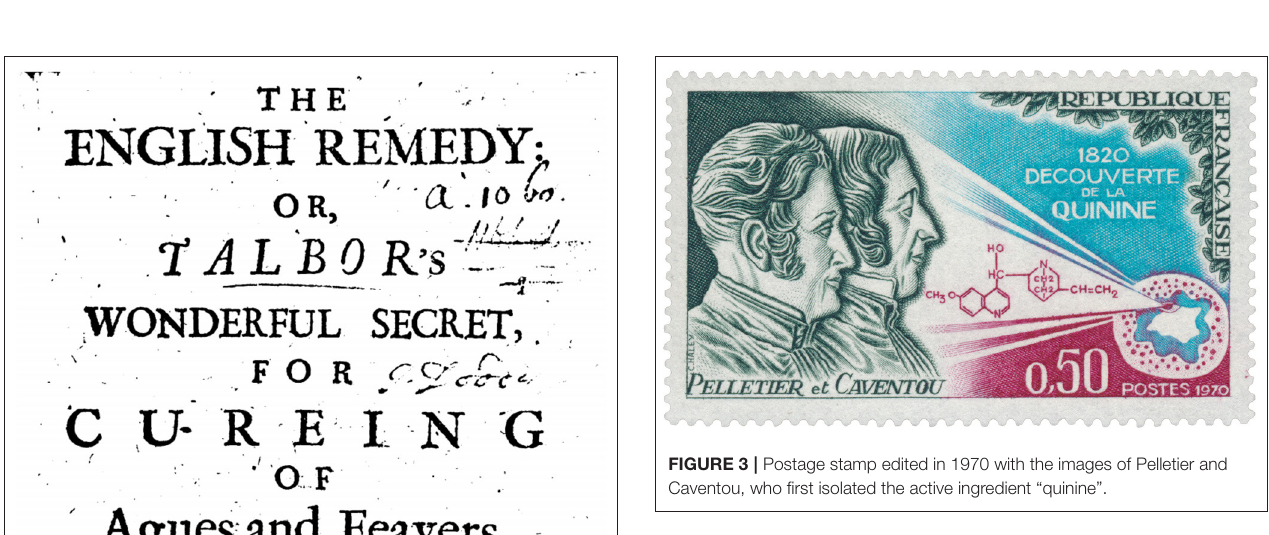
their periodicity: tertian fever from the Greek tritaios pyretos (intense fever every 3 days) and quartan fever from Greek tetartaios pyretos (intense fever every 4 days) (26). He